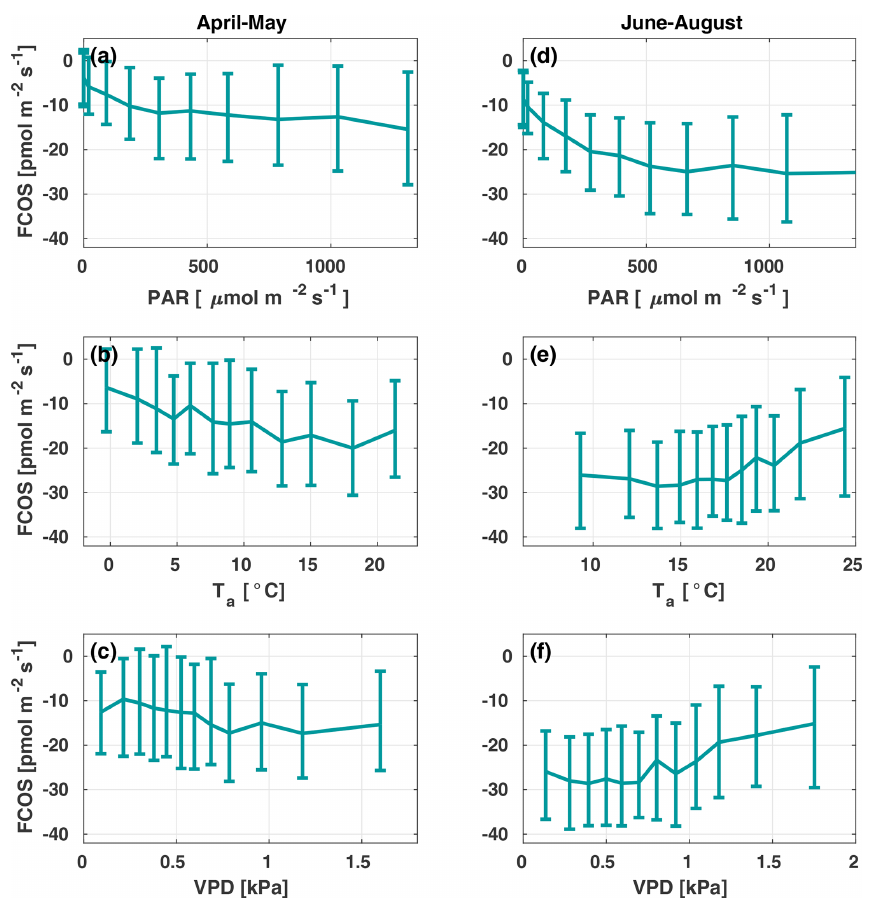
Figure 3. The carbonyl sulfide flux (FCOS) relationship with environmental variables in spring (a–c) and summer (d–f) . Panels (b) , (c) , (e) , and (f) are filtered to high radiation only (photosynthetically active radiation, PAR > 500µmolm − 2 s − 1 ). Data are binned in 12 equally sized bins, and whiskers represent the 25th and 75th percentiles. VPD represents the vapor pressure